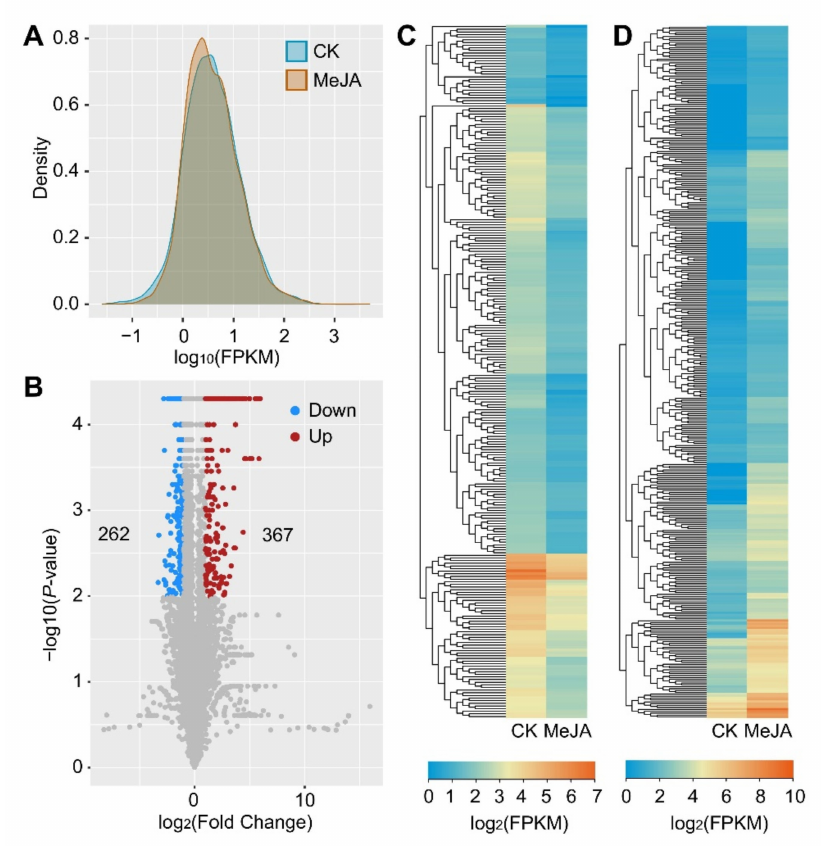
Figure 3. Differential expression analysis of MeJA-responsive lncRNAs in tobacco BY-2 cells. ( A ) Density plot of control and MeJA-treated BY-2 cell samples. ( B ) Volcano plots exploring the relationship between the fold change and the significance of finding MeJA-responsive lncRNAs ( p value ≤ 0.01; |log 2 FC| ≥ 1). ( C ) Heatmap representing 262 downregulated MeJA-responsive lncRNAs. ( D ) Heatmap representing 367 upregulated MeJA-responsive